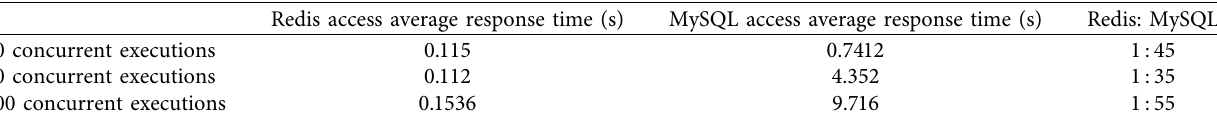
Figure 3: Average transaction response time of 100 concurrent Table 1: Summary of test results.